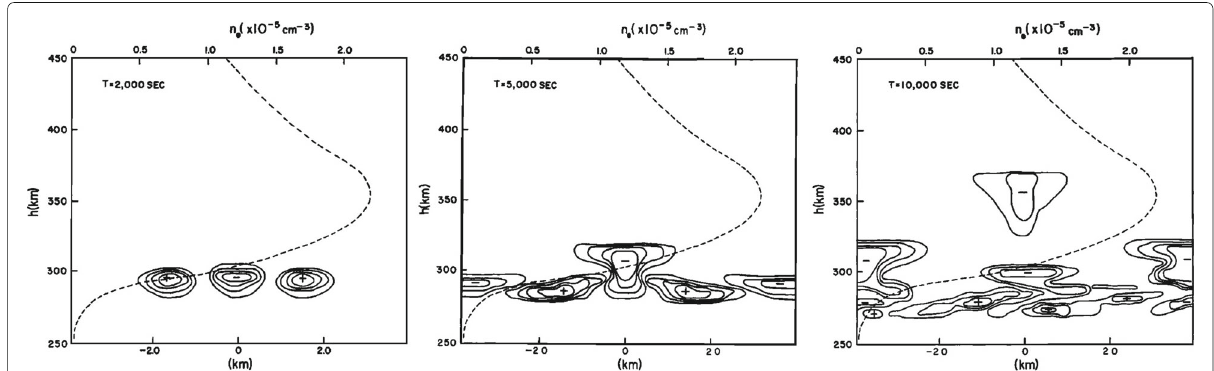
Fig. 1 The first 2D simulation of the nonlinear evolution of EPBs. Reproduced from Scannapieco and Ossakow (1976)